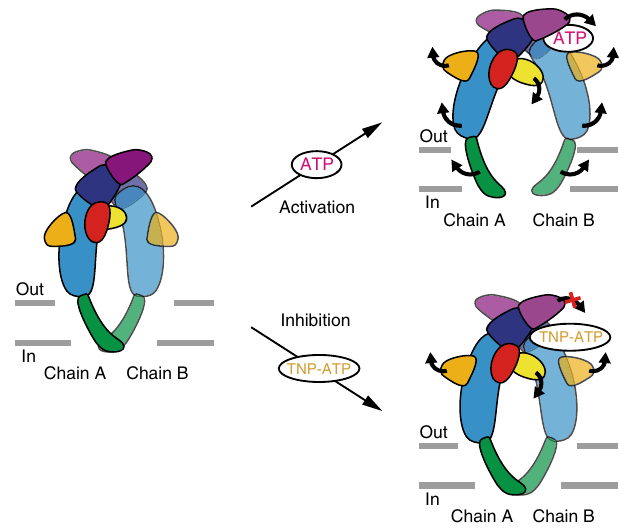
Fig. 6 Mechanism of TNP-ATP-dependent inhibition. Cartoon models of ATP-dependent activation and TNP-ATP-dependent inhibition. The black arrows indicate the movements activated by ATP from the apo, closed state ( left ) to the ATP-bound, open state ( right , above ). The black arrow with a red cross indicates the movement caused by TNP-ATP from the apo, closed state ( left ) to the TNP-ATP-bound, closed state ( right , below